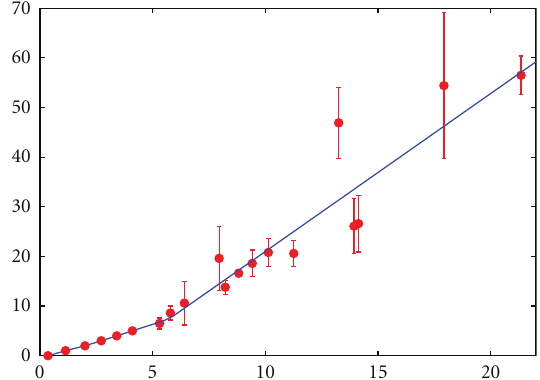
Figure 1: Comparison between median signal intensities calculated using parameters generated in this paper ( y -axis) and CN estimates obtained in a di ff erent way ( x -axis). For details see Table 1. Blue line represents correlation between median signal intensities and CN values used in this